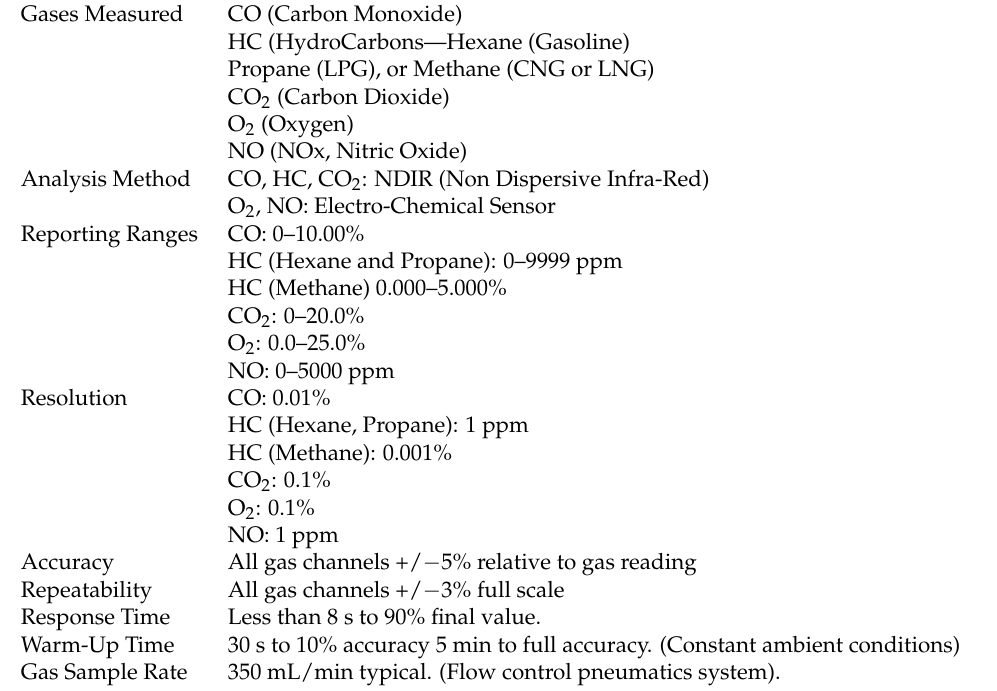
Table 1. Gas analyser specifications.